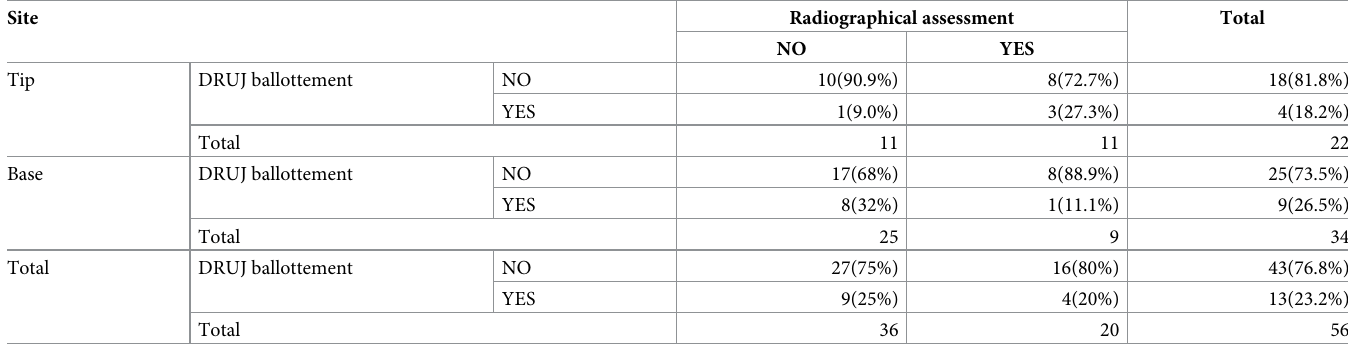
Table 2. Shows DRUJ ballottement with radiographical assessment and site of the fracture.